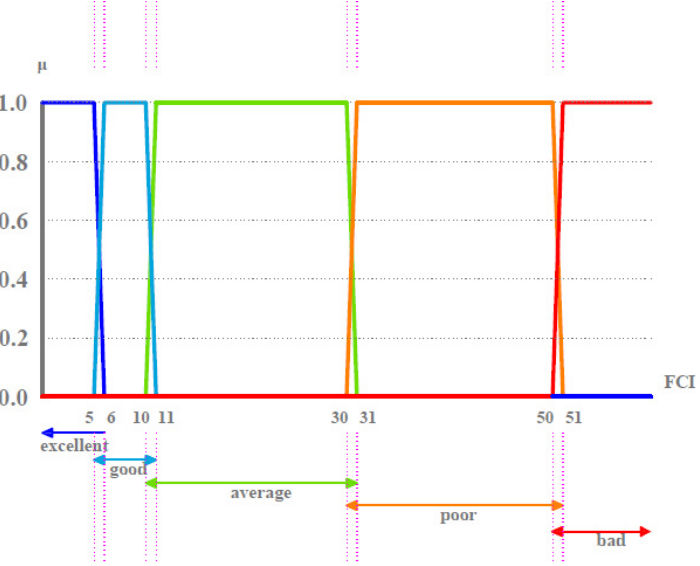
Figure 9. Membership functions of the condition scale for Facility Condition Index